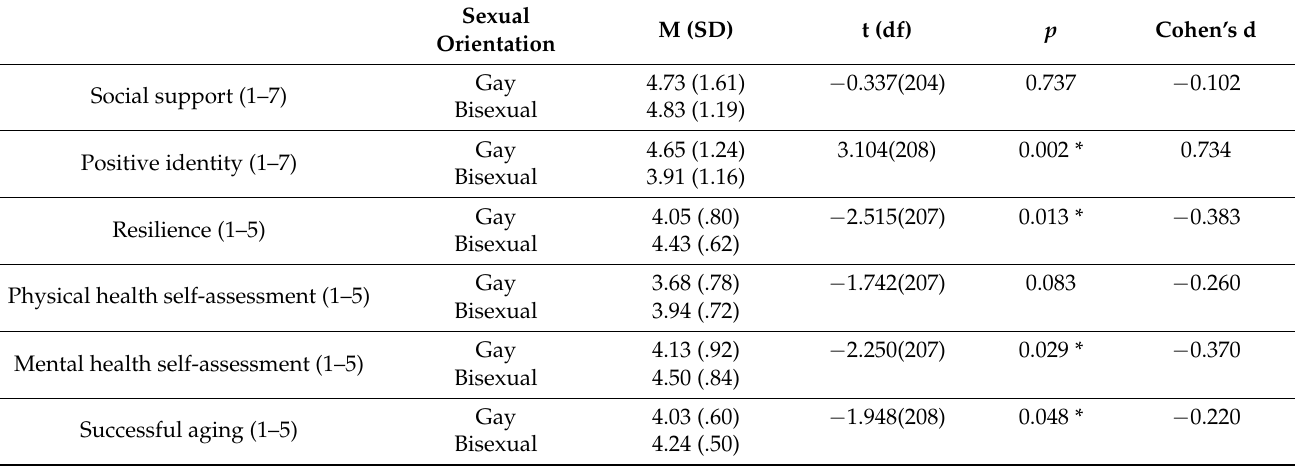
Table 2. Social support, positive identity, resilience, physical and mental health, and successful aging results by sexual